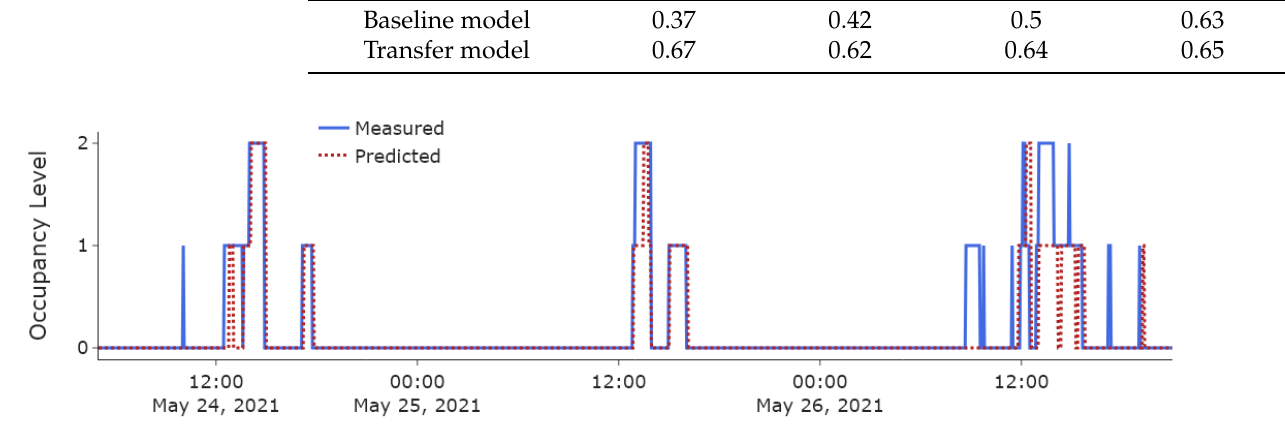
Figure 8. Showcase of the occupancy level prediction using the transfer model with one day retraining